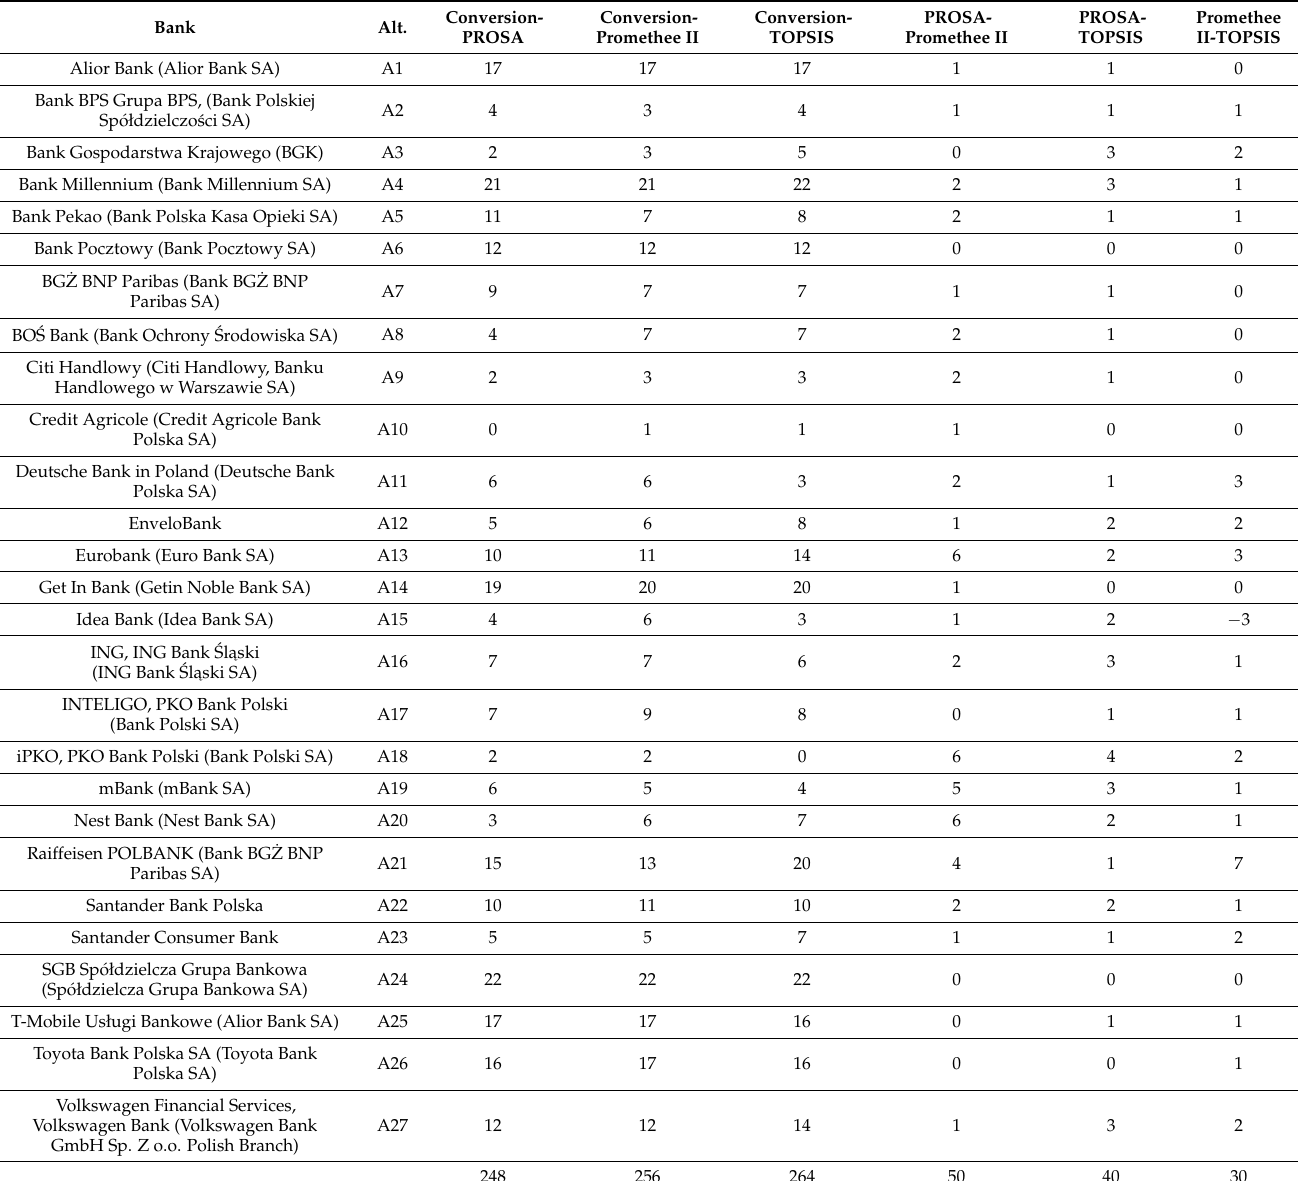
Table 8. Differences in absolute scores between the ratings of places in the rankings obtained using the conversion method and the results obtained using the Promethee II, PROSA, and TOPSIS methods (city distance).